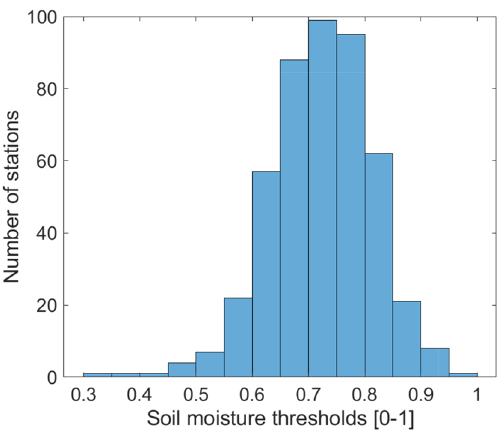
Figure 2. Histogram of soil moisture thresholds identified for all basins.